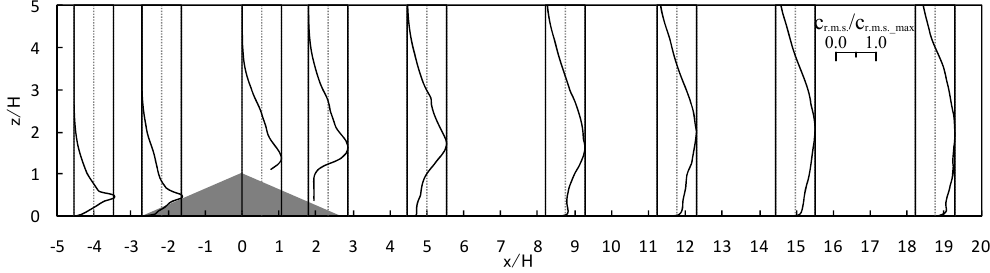
Fig. 8. Streamwise variation of vertical profiles of r.m.s. concentration. Figure 8. Streamwise variation of vertical profiles of r.m.s.